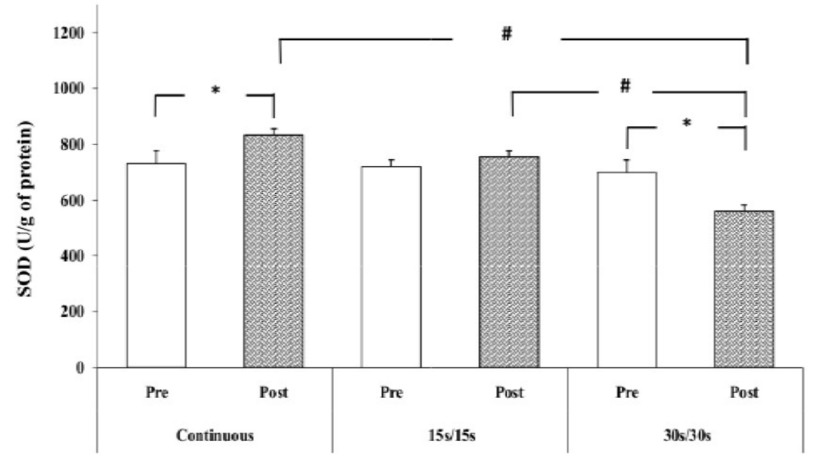
Figure 4. SOD activity at rest and immediately after